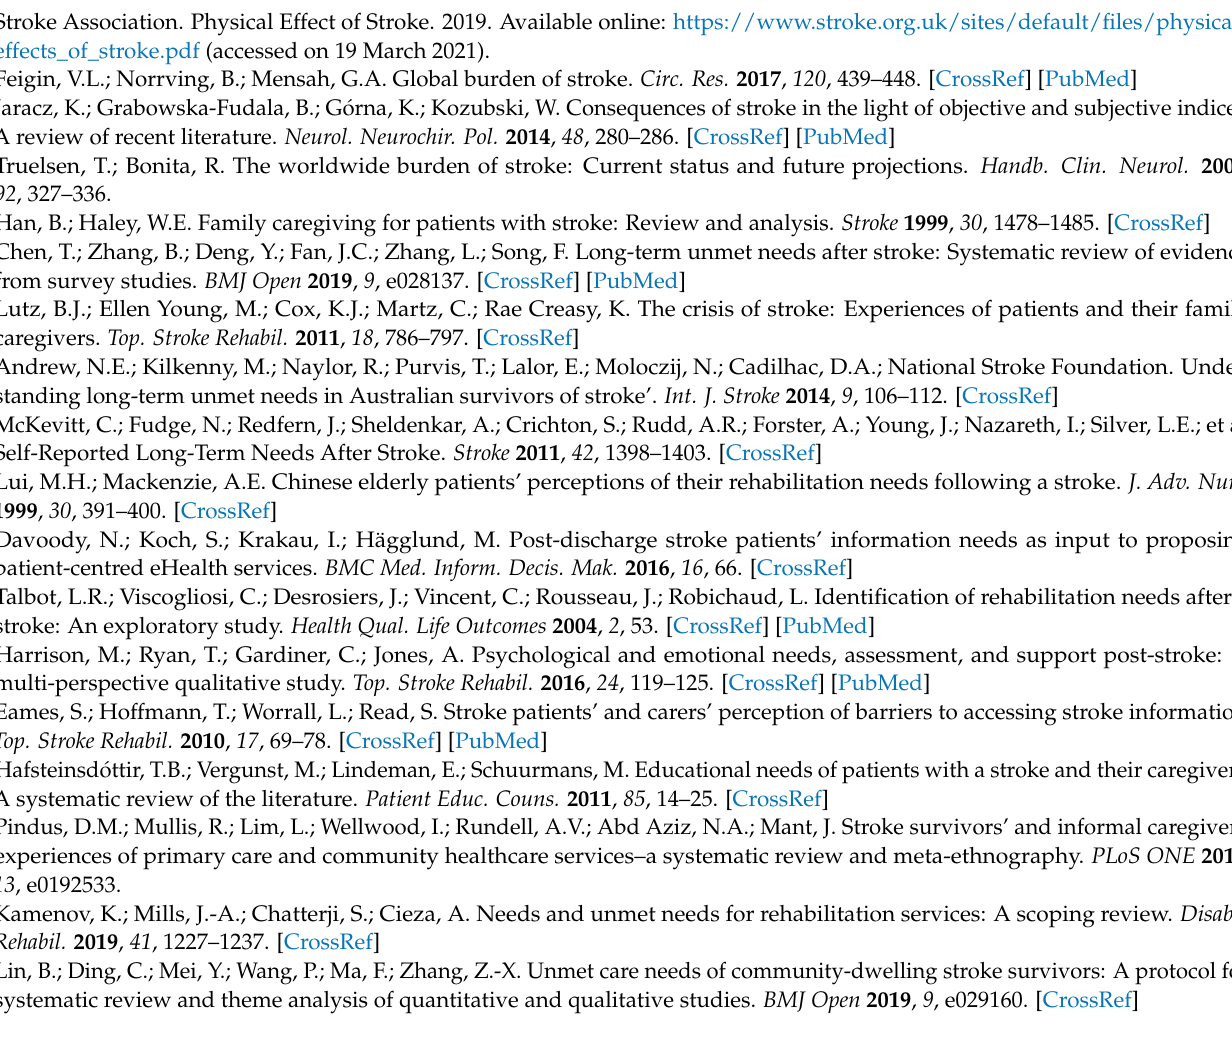
Table S3: example of